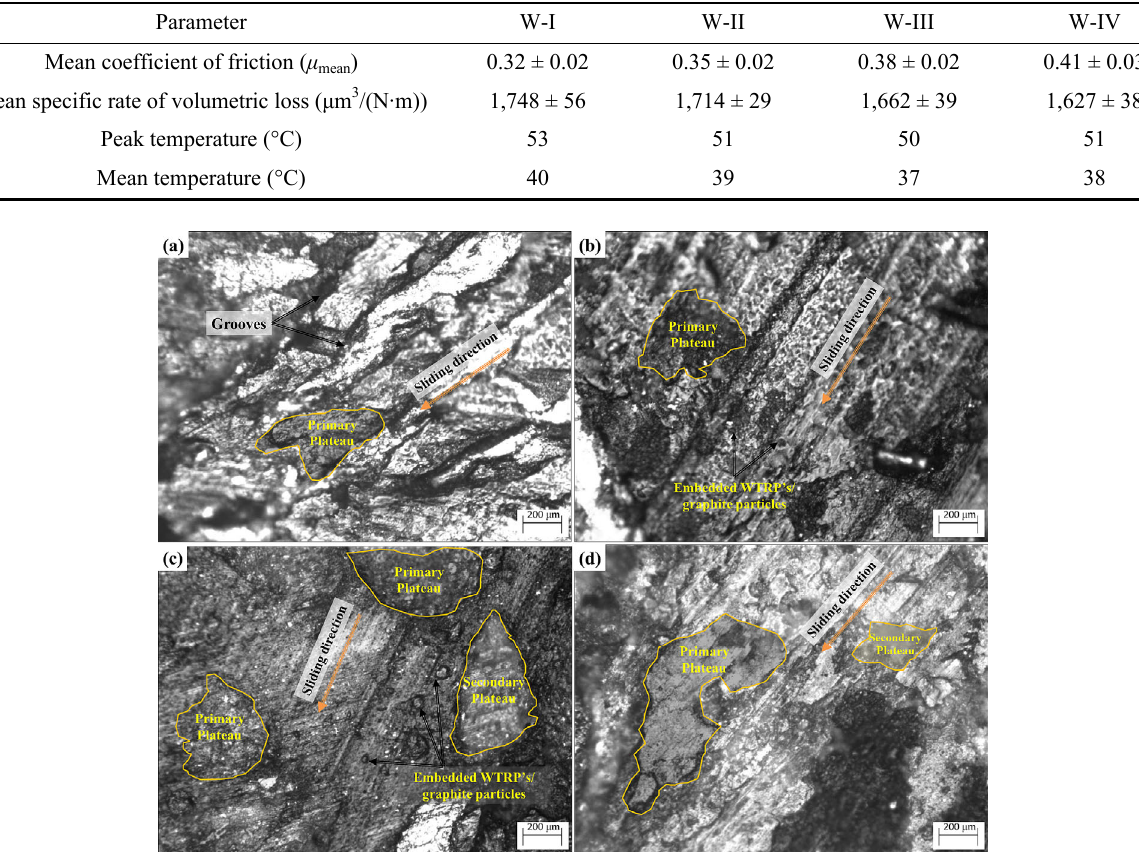
Fig. 10 The specific rate of volumetric loss  V for (a) W-I, (b) W-II, (c) W-III, and (d) W-IV. Table 6 Tribological response of the brake linings.